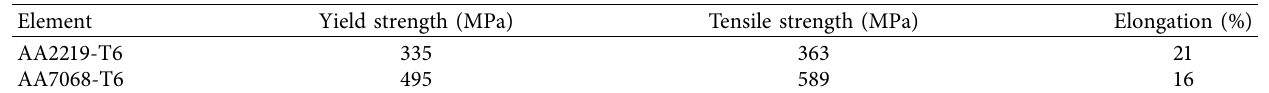
Table 2: Dissimilar alloys’ mechanical